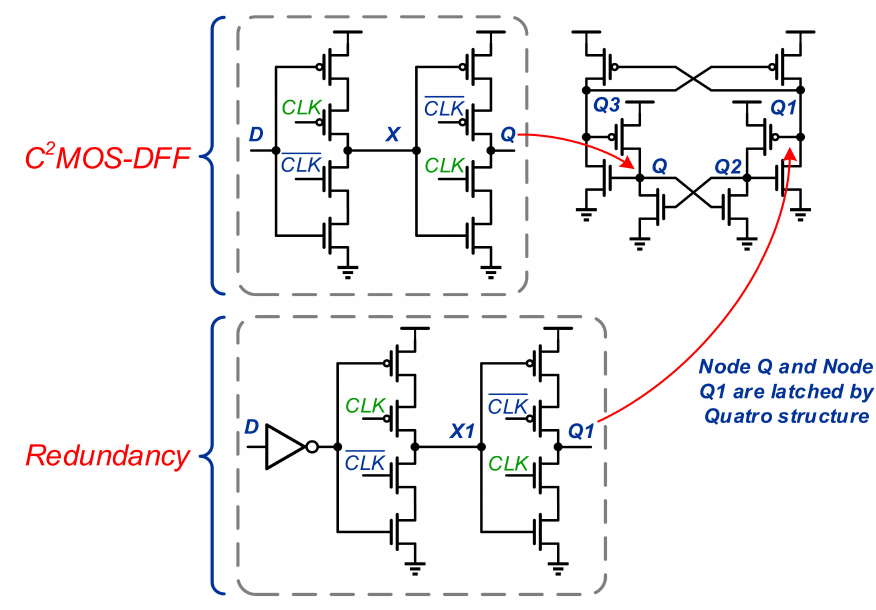
Figure 14. Schematic diagram of C 2 MOS-Quatro.